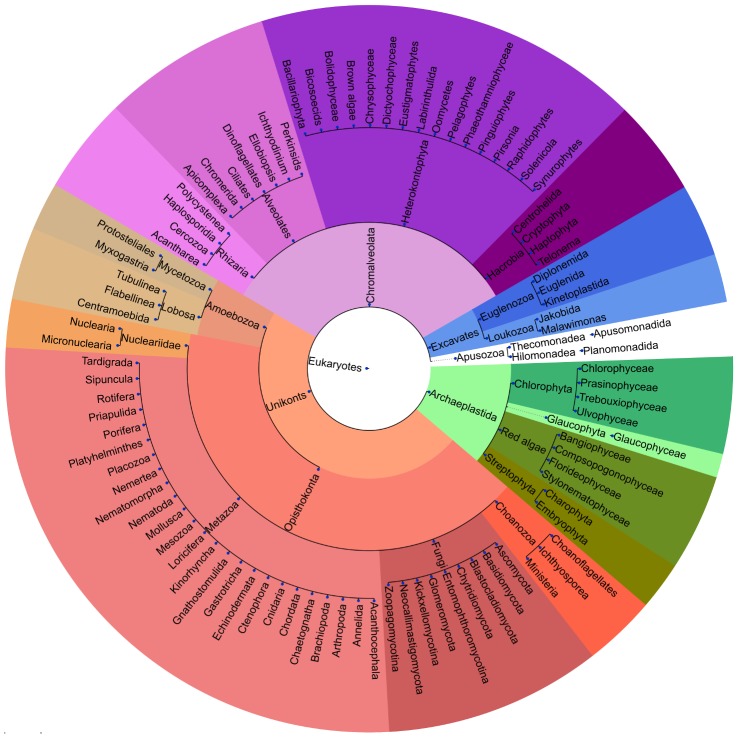
Empirical primer test on marine sediments.Taxonomic coverage of reads from 454 pyrosequencing on pooled DNA extracts from three different marine sediments from the Norwegian continental shelf. The figure indicates lower rank levels of the taxonomic tree of the best hits after running BLAST on representative sequences of 6823 OTUs against the SILVA database.